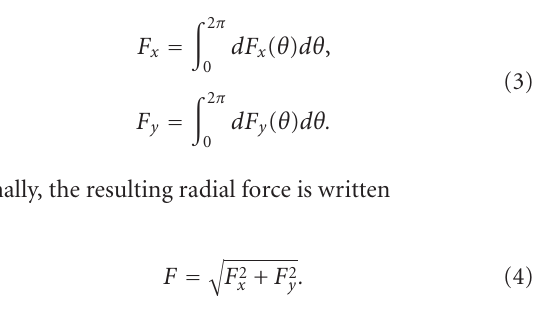
Figure 17: Static pressure distribution at the impeller periphery, for Q/Q = 1 and a = 0 ◦ bep